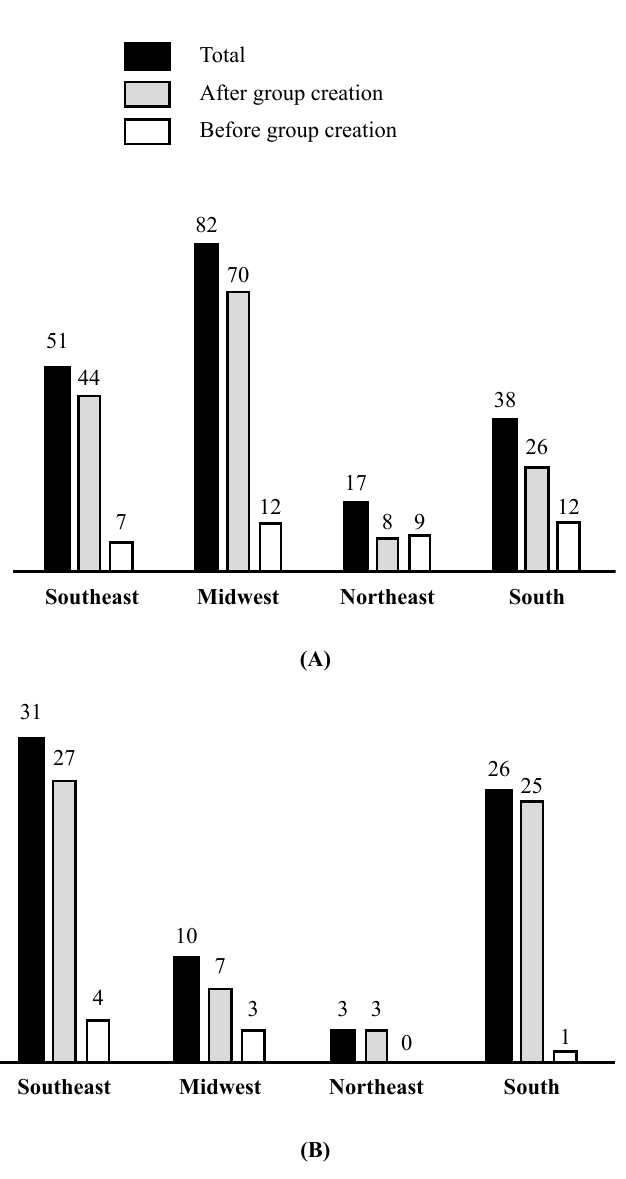
Figure 3. A) General scientific production on cancer of RGIDEC leaders from different Brazilian regions until January 2017. B) Specific scientific production on cancer and intervention with exercise and/or diet of RGIDEC leaders from different Brazilian regions until January 2017. There were no study groups in the northern region of